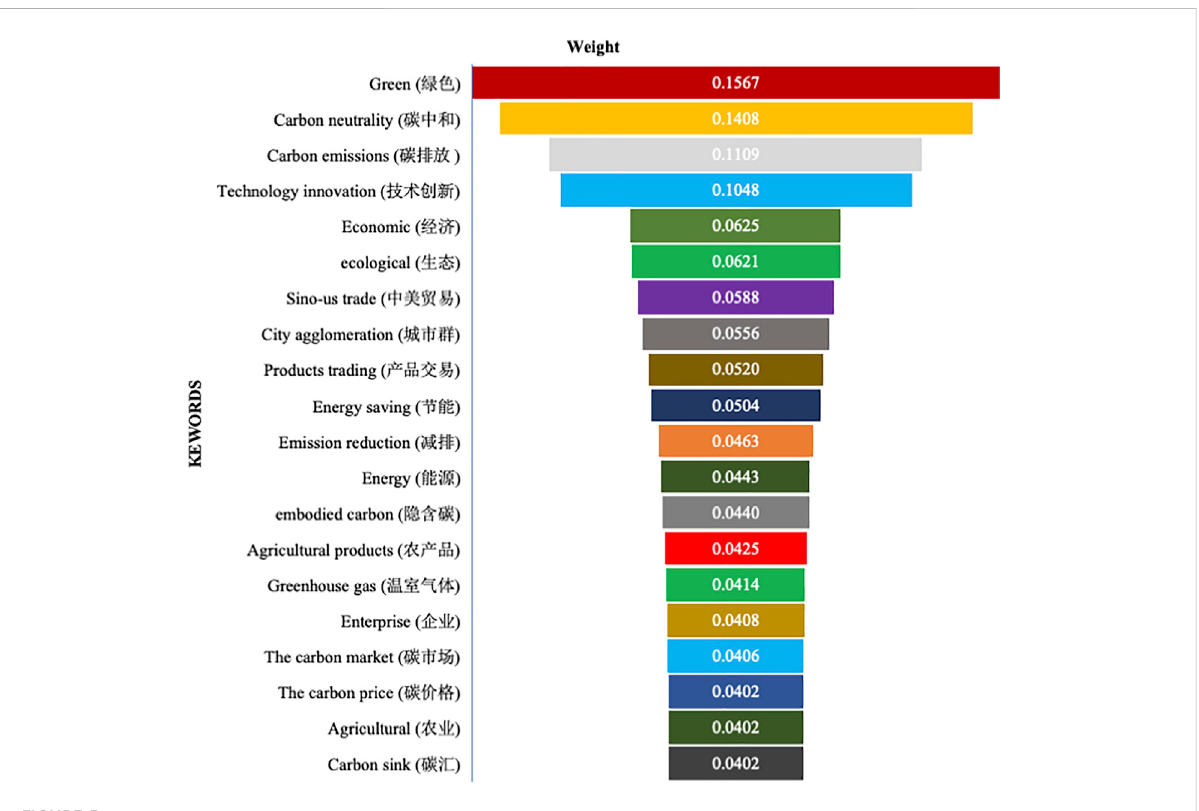
FIGURE 5 Keywords top